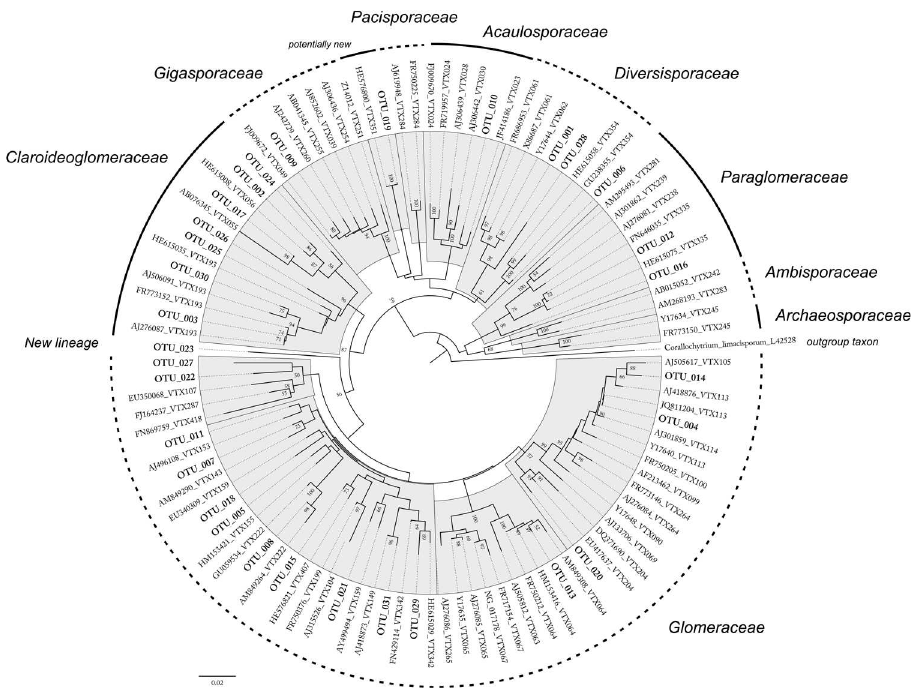
Fig 2. Phylogenetic tree showing the placement of the AM fungal OTUs associated with B . subacaulis . Referencesequenceswere retrieved from the MaarjAM AMF Virtual Taxa database[41]. Corallochytrium limacisporum (L42528)was used as the outgrouptaxon.